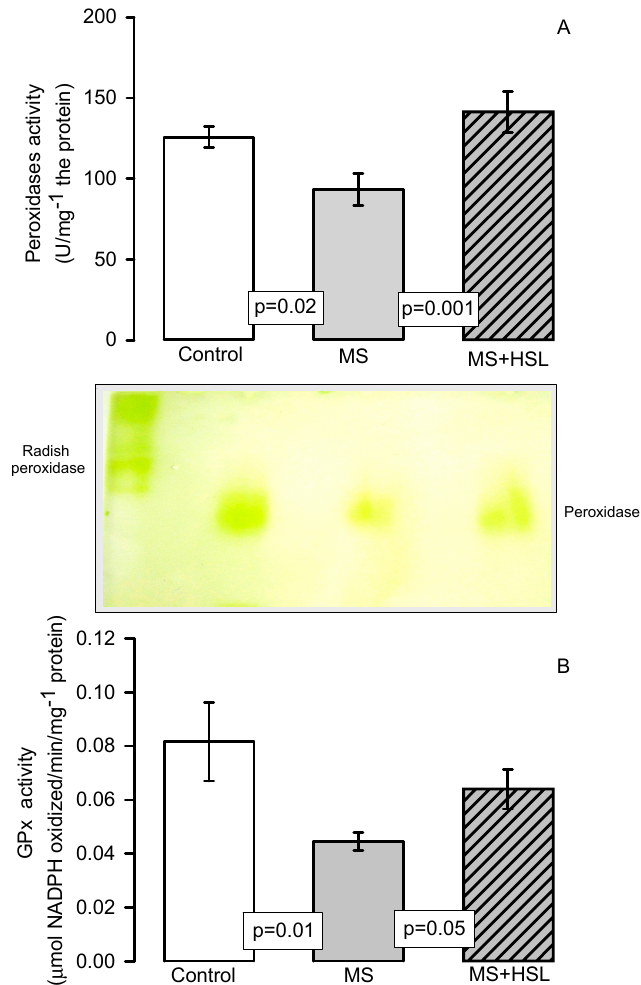
Figure 6. Peroxidase activity ( A ) and GPx activity ( B ). Panel ( A ) densitophotometric analysis of the activities of peroxidases, a representative native gel is shown below the histogram. Where peroxidases are present, the gel remains transparent and the 3, 3, 5, 5-tetramethylbenzidine is oxidized, showing a green coloration. Abbreviations: MS = metabolic syndrome, MS + HSL = metabolic syndrome plus Hibiscus sabdariffa L., GPx = glutathione peroxidase. Data are expressed in means ± SE, ( n = 8, rats in each group). Statistical significance was determined by one-way ANOVA test, followed by Tukey’s post hoc